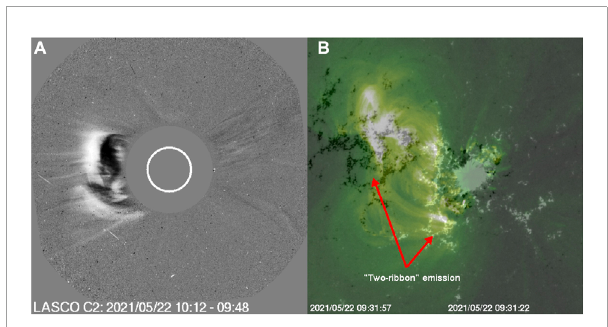
FIGURE 9 (A) Largest CME observed during 21–23 May 2021. (B) Low coronal response of the